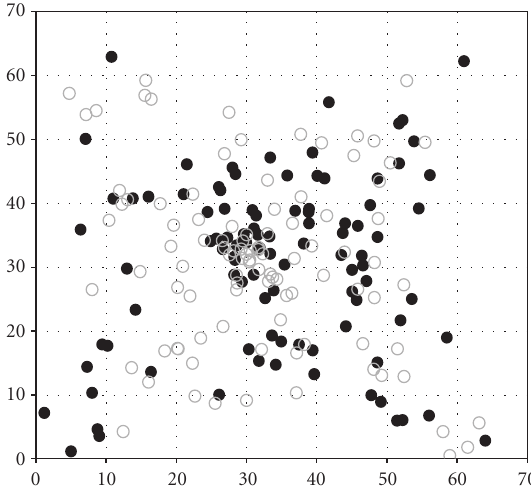
Figure 5: Inhomogeneous point set, Point map. All points are drawn from an inhomogeneous Poisson point process.